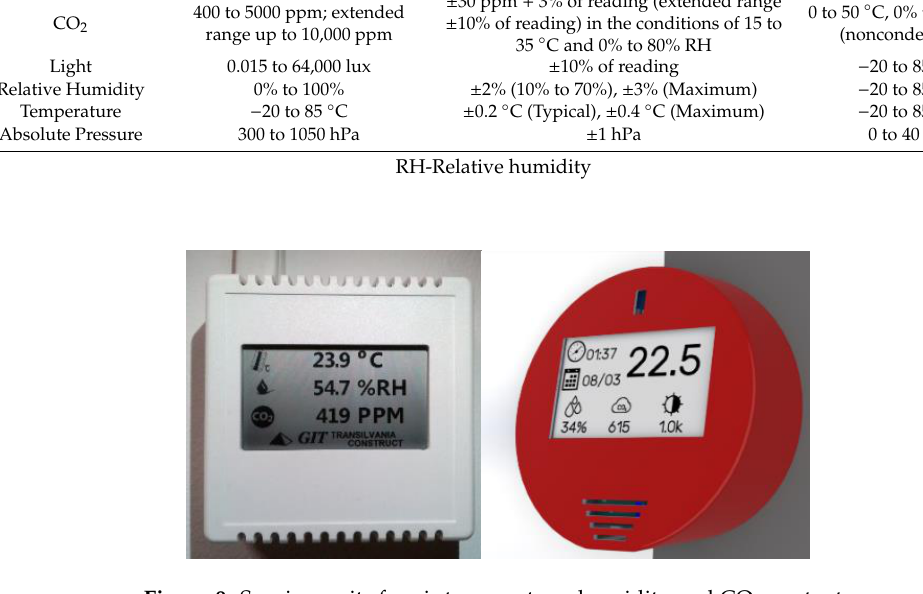
Table 4. Accuracy specifications for the sensing devices.